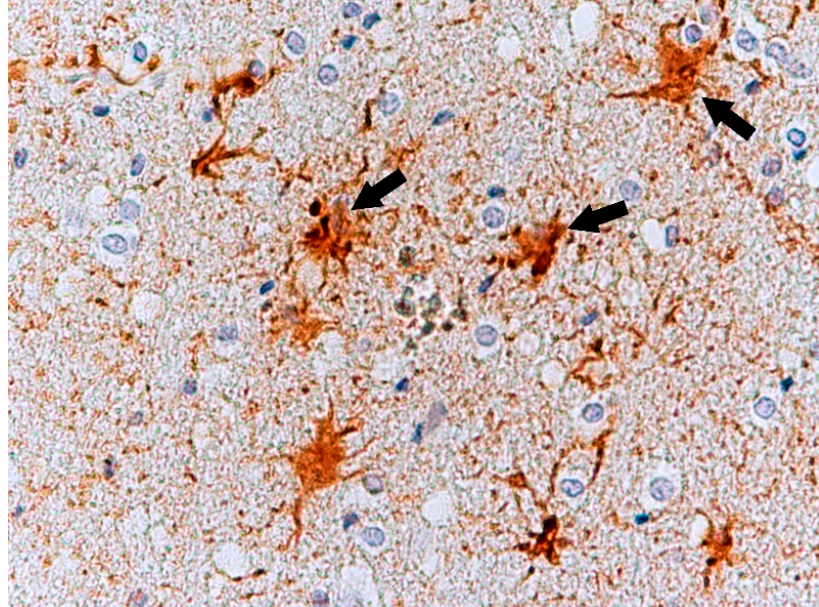
Figure 6. Case no. 3. Frontal lobe of the cortex. Neuropathological changes, damage and fragmen ‐ tation of astrocytes processes (arrows, clasmatodendrosis). Positive immunohistochemistry reaction with GFAP. Magnification 400×.